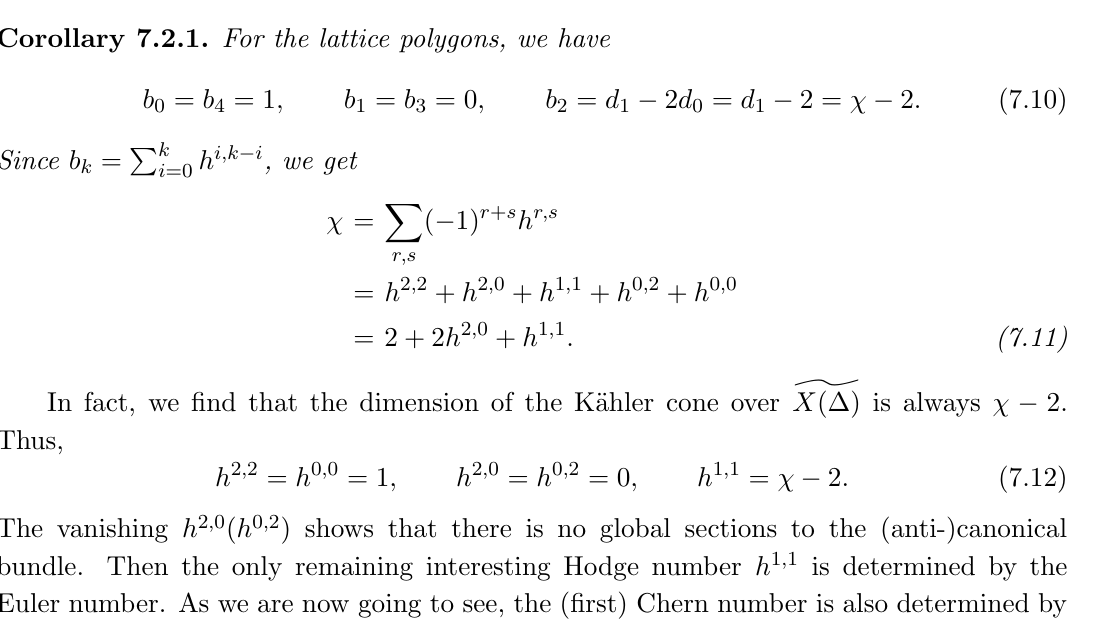
Figure 3. The reciprocals of minimized volumes against the number of lattice points N . This is bounded by the straight line 1 =V min = N where the triangles